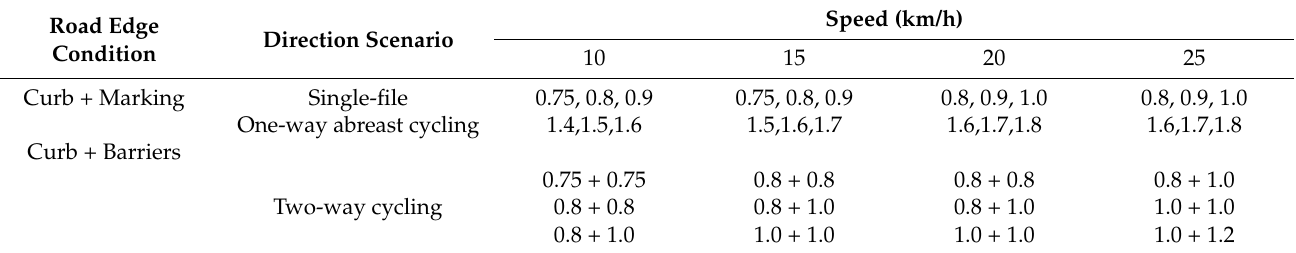
Table 4. Different scenarios and width arrangements of the test road (m).